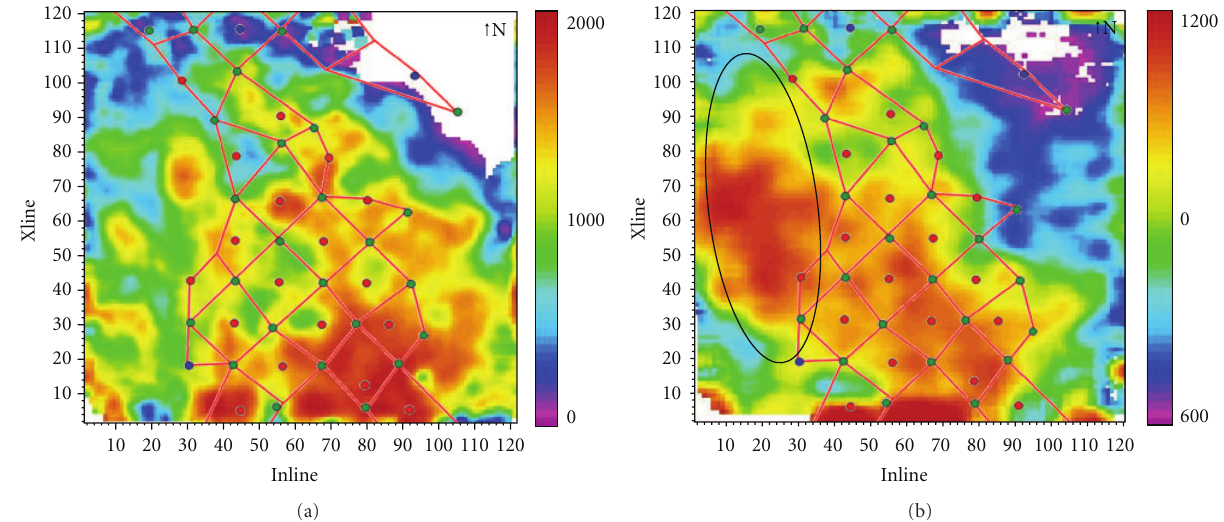
Figure 19: (a) P-wave amplitude map and (b) S1-wave amplitude map are shown with well pattern overlaid on them (green dots represent producer wells; red dots represent injector wells). The amplitude map is obtained by computing sum of positive samples in a 0.035s window centered around peak doublet for P-wave and 0.05s window centered around peak for S1-wave. The S1-wave amplitude shows better match with the well pattern, except in the western part of the study area (shown by black oval) where there is presence of Morrow A1 sandstone (Figure 20(b)).